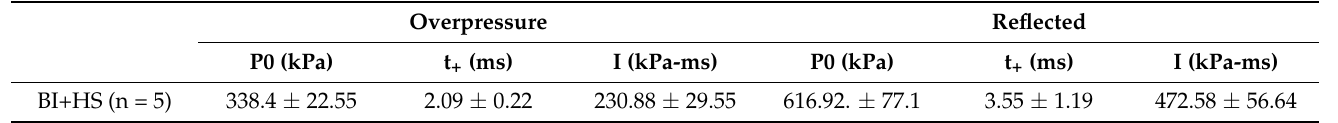
Table 1. Blast wave parameters obtained from the shock tube. Overpressure